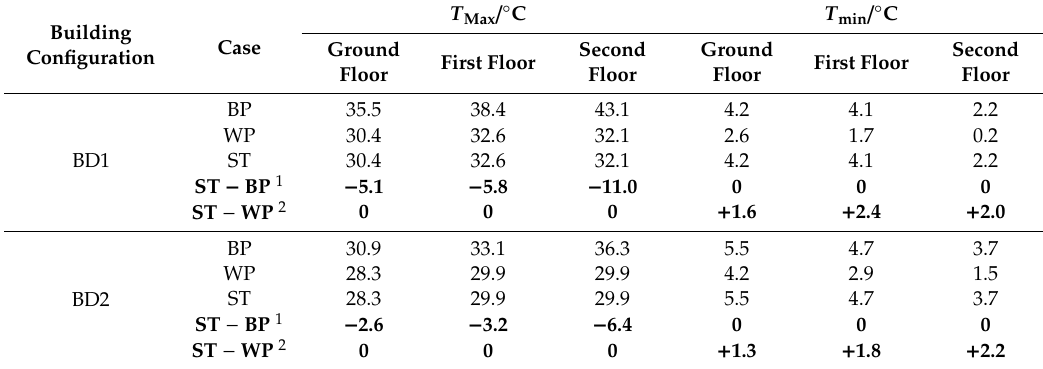
Table 5. Average maximum indoor temperature ( T Max ) over the hottest week of the year and average minimum indoor temperature ( T min ) over the coldest week of the year, for a building painted with an optimized thermochromic step transition paint (ST), located in Madrid, Spain.